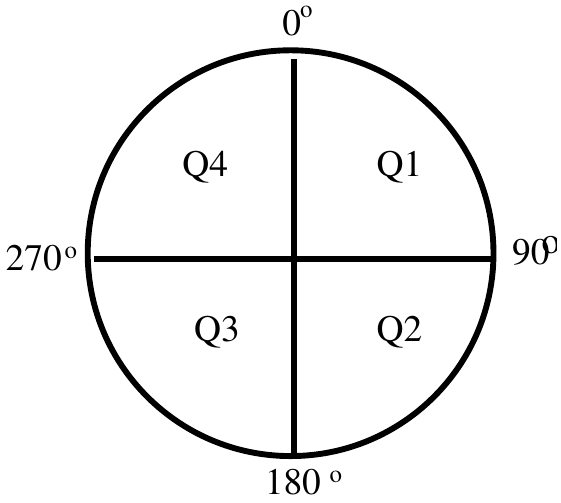
Figure 2. Definition of crank angle and quadrants during